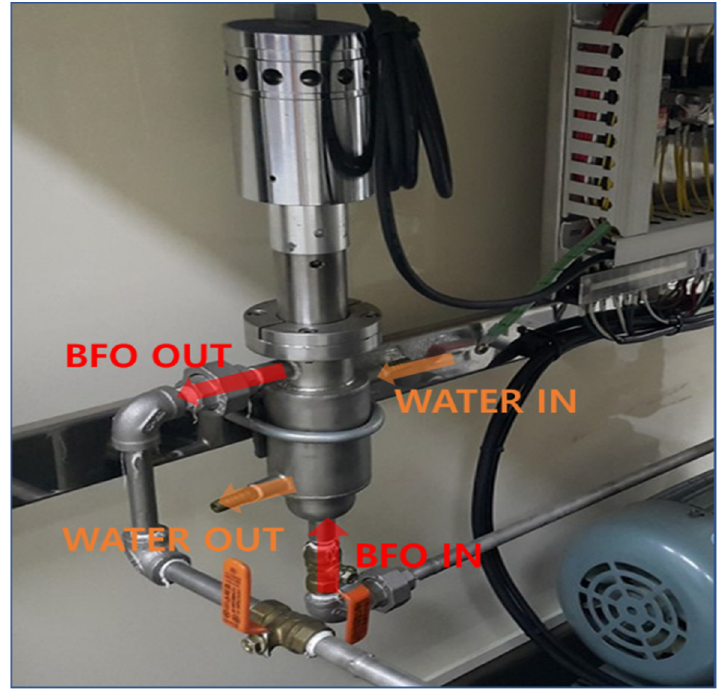
Figure 1. Photograph of ultrasonic reactor equipment.